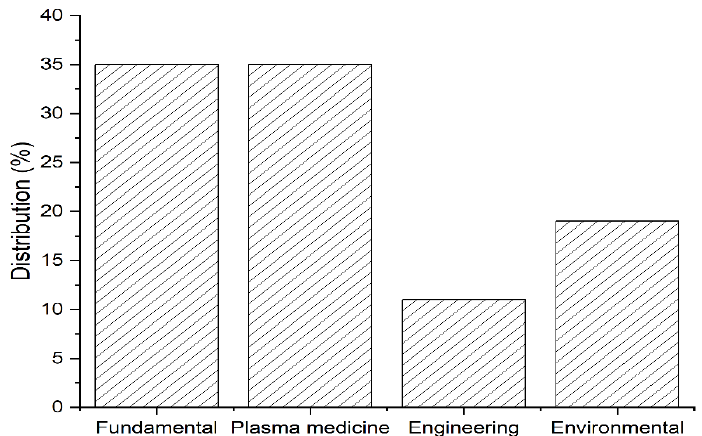
Figure 2. Macro-research fields of the included studies in this review. Fundamental [21,41–47,50,52,54,58,59], plasma medicine [20,22,31,32,38–40,48,49,51,55,56,60], engineering [24–26,53], and environmental [19,23,27–30,57].